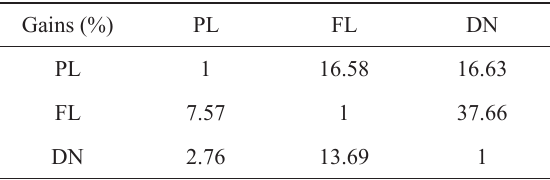
Percentage of indirect participation in the direct gain in the three